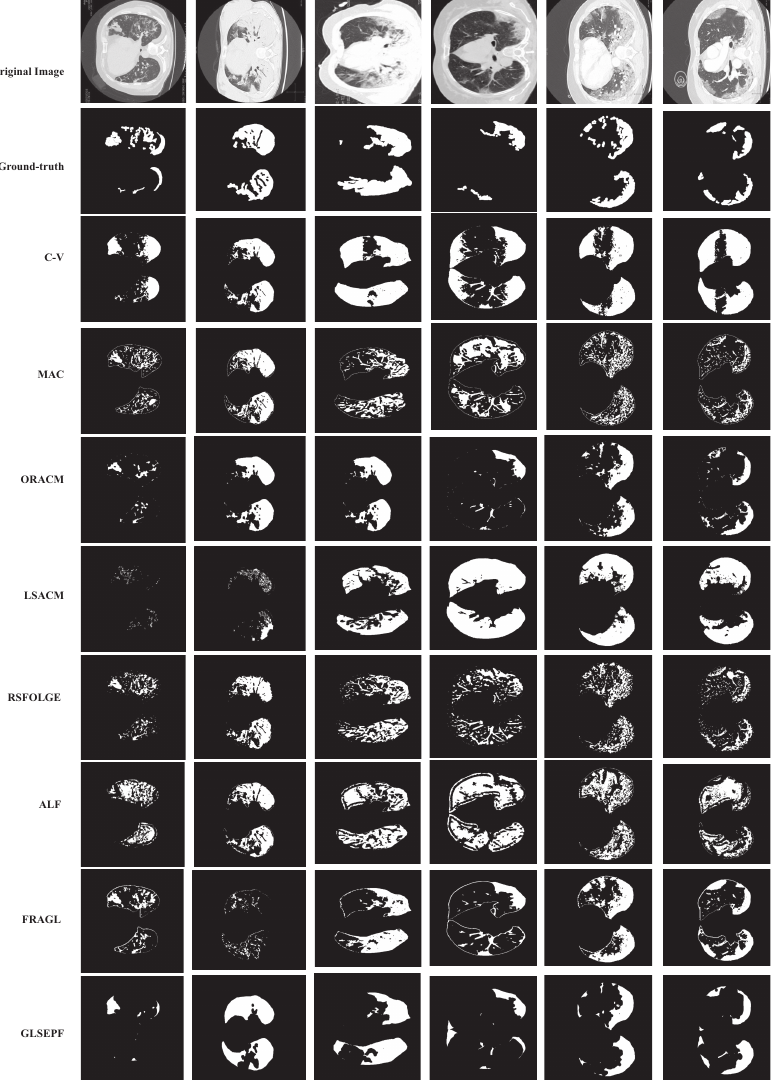
Figure 9. Outcomes of all active contour models in terms of the database. Table 4. Comparison of the best active contour method with deep learning methods in terms of the Recall measure. MiniSeg MobileNet